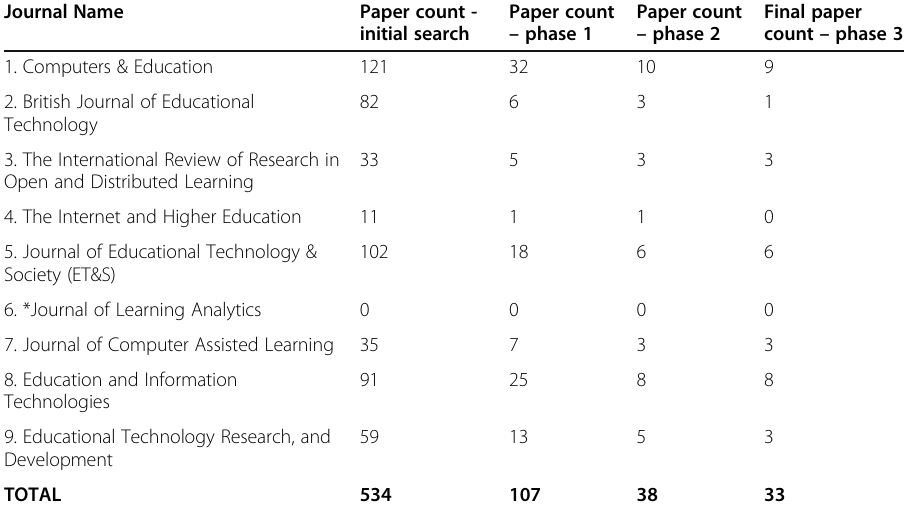
Table 3 Result-set size for the number of papers of “ personalized learning ” during each research phase by the